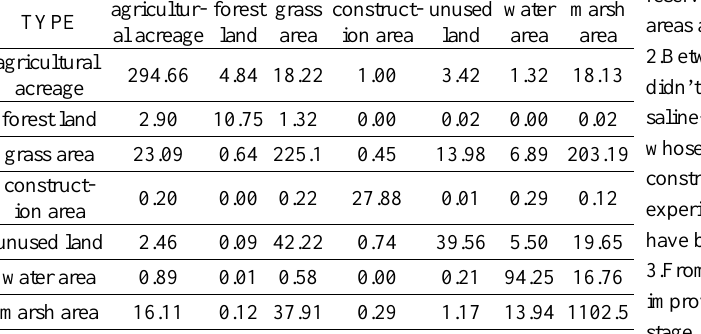
Table 4. Data transfer sketch map from 2000 to 2013